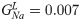
Action potential in interneurons from NTG mice exhibit rapid onset as compared to those from APdE9 mice.(a) Phase plots showing the derivative of membrane potential as a function of instantaneous membrane potential during action potential spike in interneurons from NTG mice (blue) and APdE9 mice (red) observed experimentally are reproduced from Fig 3(c) for comparison. Phase plots given by the model at GNaL=0.007 mS/cm2 (blue) and GNaL=0.028 mS/cm2 (red) (c), Gh = 0.05 mS/cm2 (blue) and Gh = 6.5 mS/cm2 (red) (e), and GNaF=24 mS/cm2 (blue) and GNaF=16 mS/cm2 (red) (g) mimicking interneurons from NTG and APdE9 mice respectively. Panels (b), (d), (f), and (h) are extended views of (a), (c), and (e), and (h) respectively.